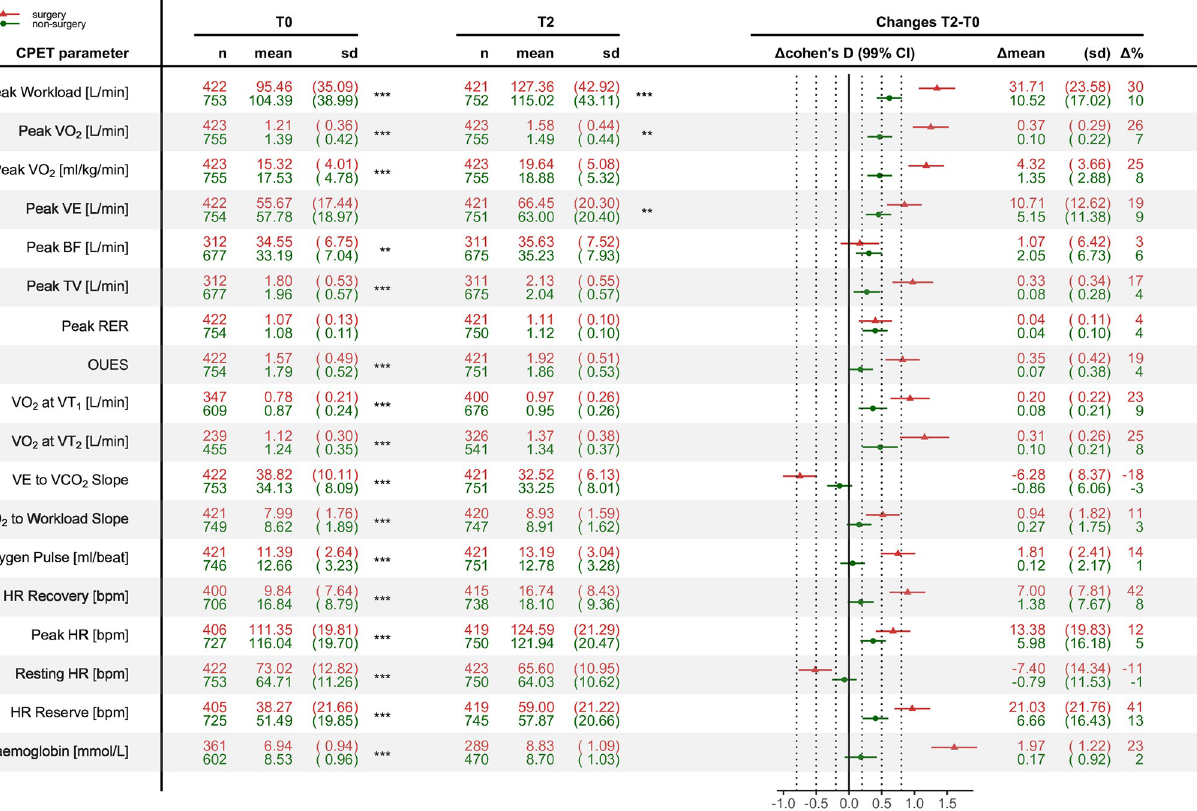
Fig 2. CPET characteristics in surgery and non-surgery patients. Shown are mean and standard deviation of all CPET and exercise related parameters at start of CR (T0) and 1 year follow-up (T2) as well the changes as standardised effect size (cohen’s D). Cohen’s Ds of 0.2 indicate a weak, 0.4 a medium and 0.8 a large effect size. VO2, oxygen consumption; VE, ventilation; BF, breathing frequency; TV, tidal volume; RER, respiratory exchange ratio; OUES, oxygen uptake efficiency slope; VT, ventilatory threshold; HR, heart